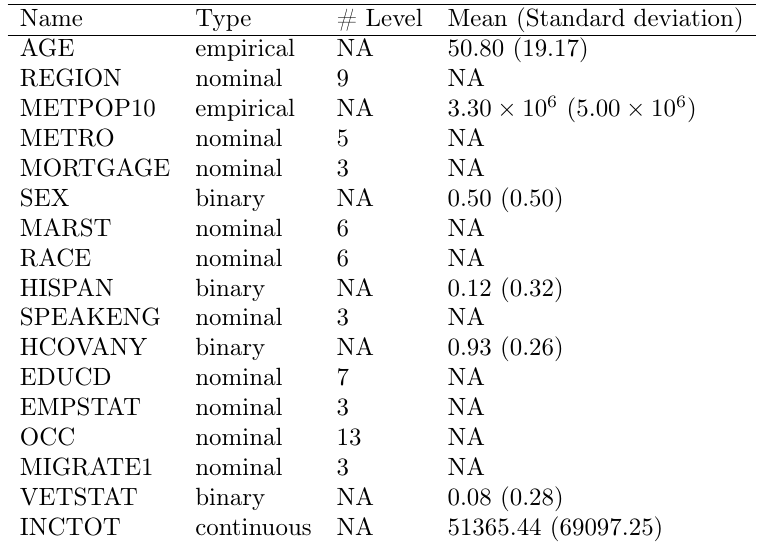
Table 3. Summary statistics for variables used in the American Community Survey anal- ysis, including variable’s names (Name), types (Type), the number of levels for nominal variables (# Level), as well as the mean (Mean) and standard deviation (Standard devia- tion). Here NA means “Not